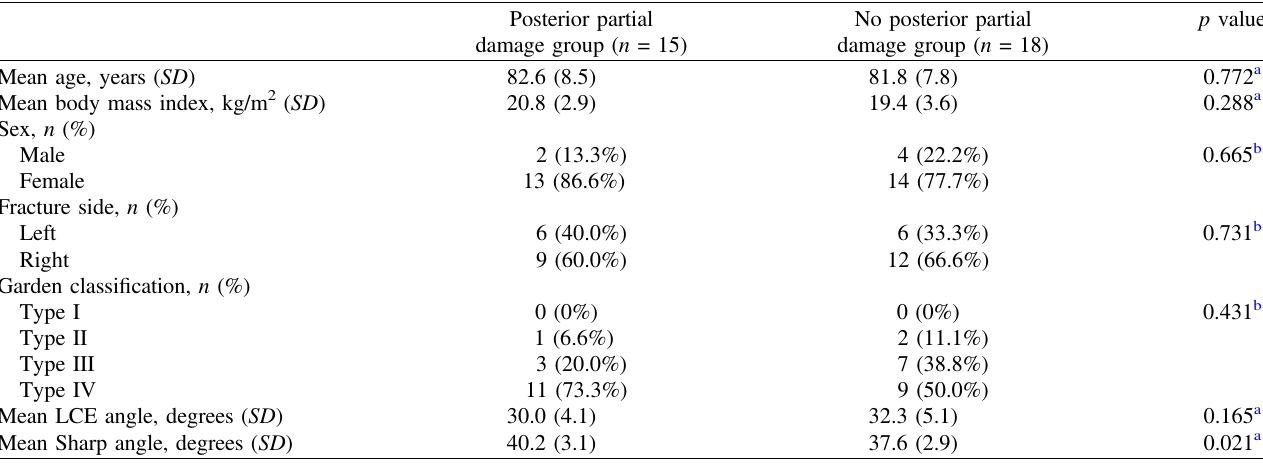
Table 3. Comparison of clinical and radiographic features between the posterior partial damage and no posterior partial damage groups.